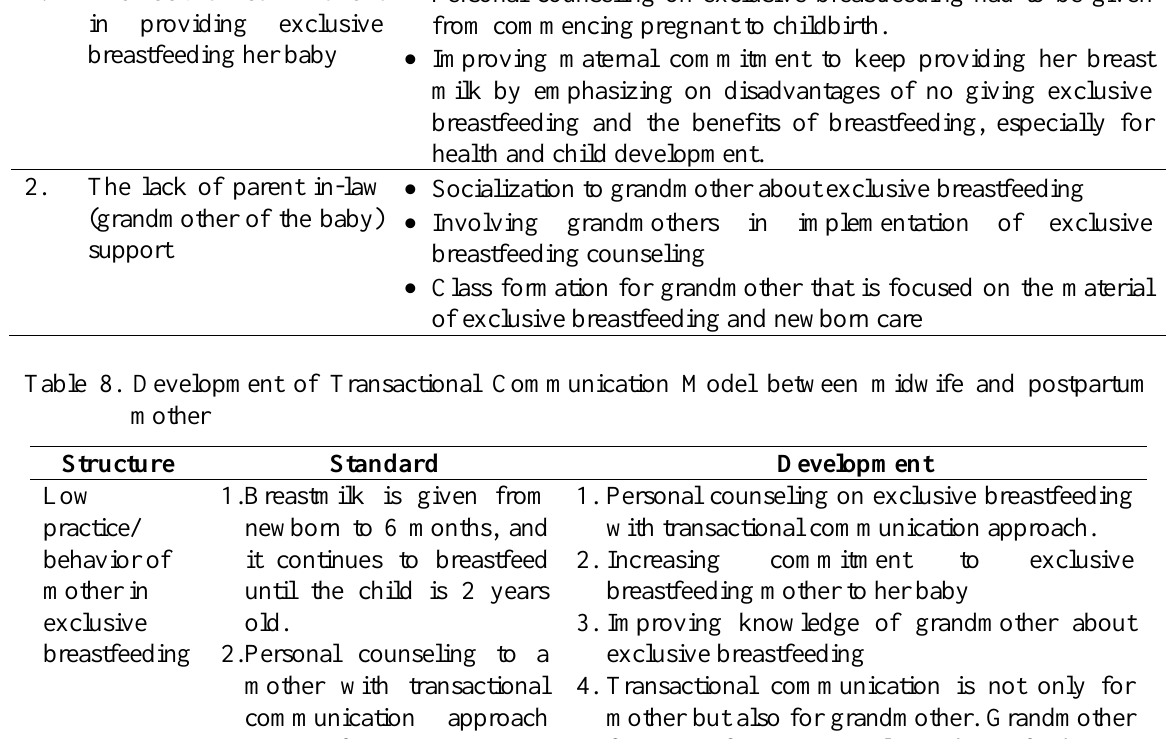
Table 7. The result and recommendation of FGD No Theme